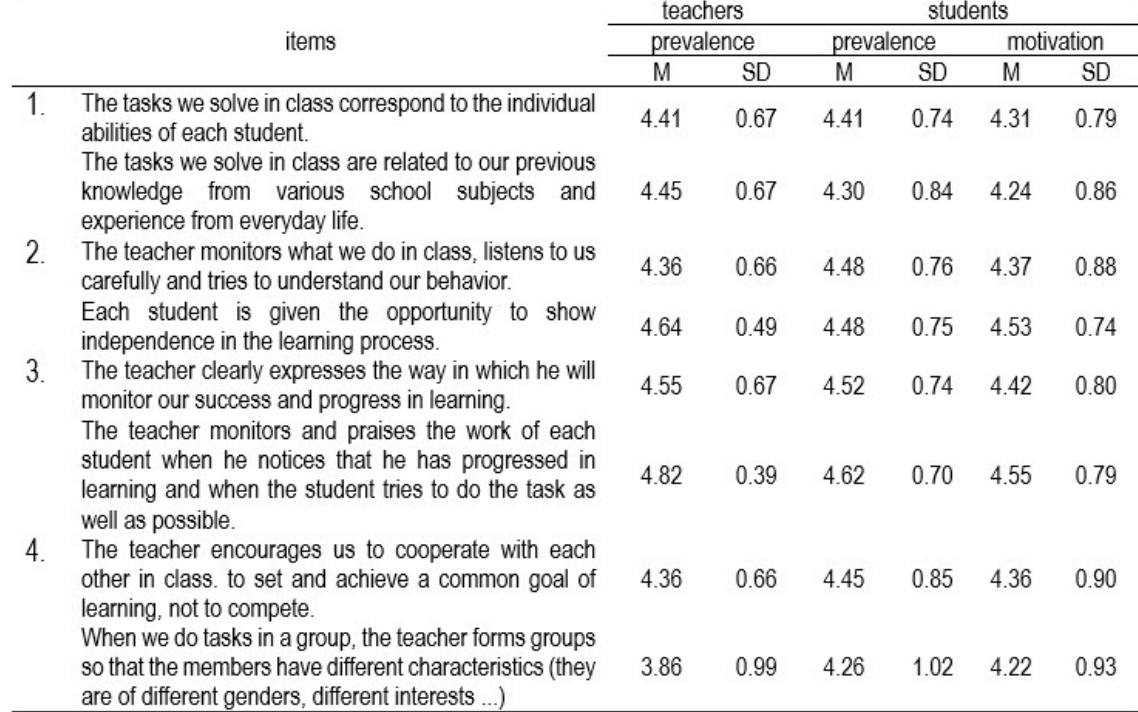
Descriptive statistics of evaluation of items in Preparation of the teaching process segment (1 - Preparation of assignments for students; 2 - Support for student autonomy; 3 - Recognition; 4 - Forms of group